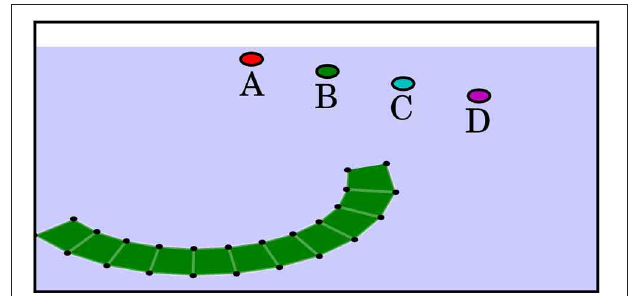
FIGURE 8 | Visualization of the octopus arm task. The circles represent target objects used in different tasks which yield an external reward when